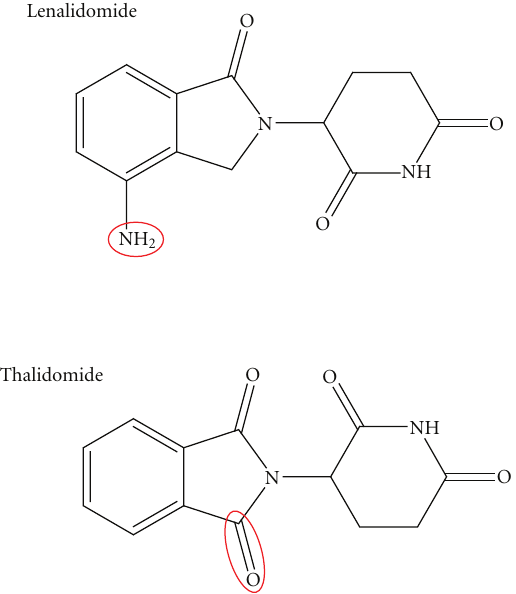
Figure 1: Lenalidomide and thalidomide